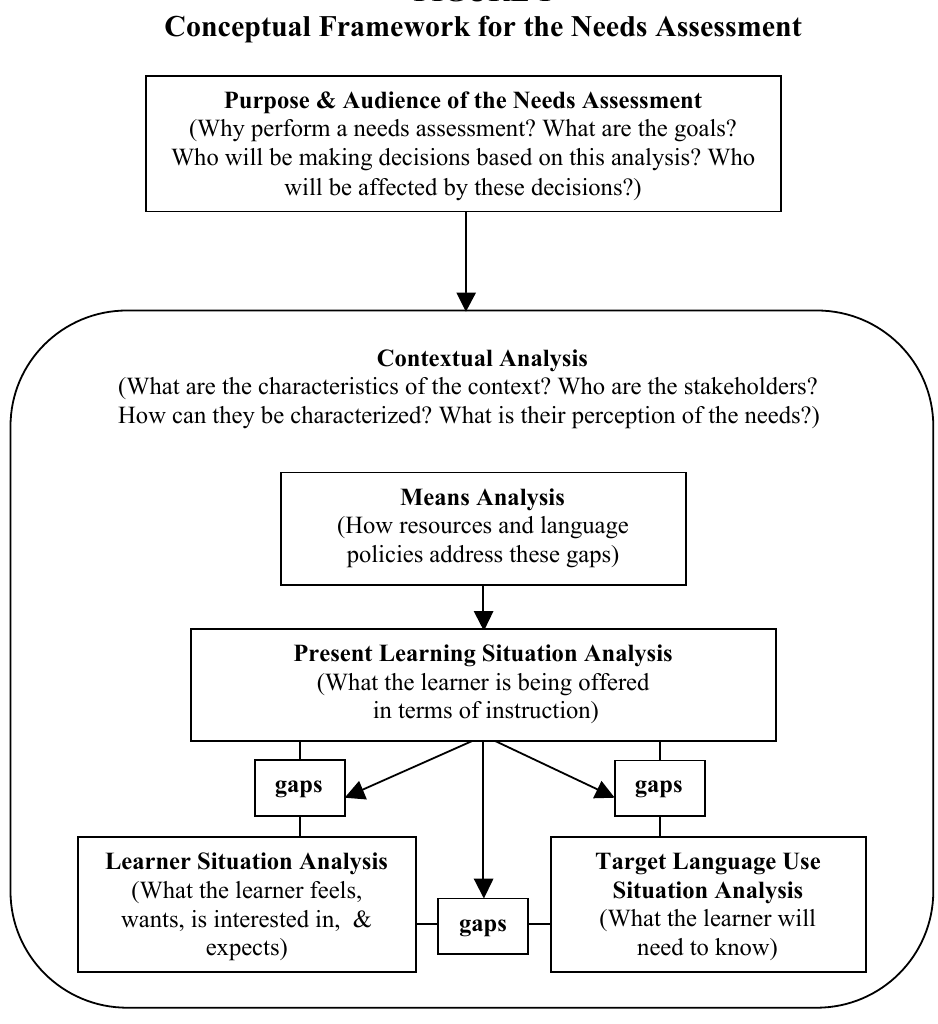
Conceptual Framework for the Needs